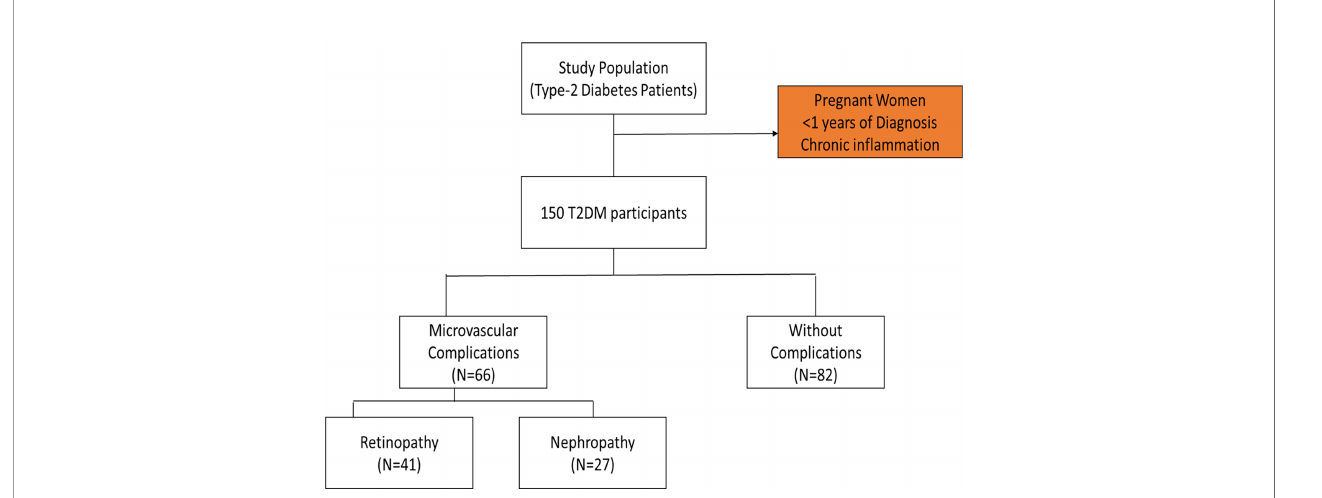
FIGURE 1 | Flow diagram of the participant selection